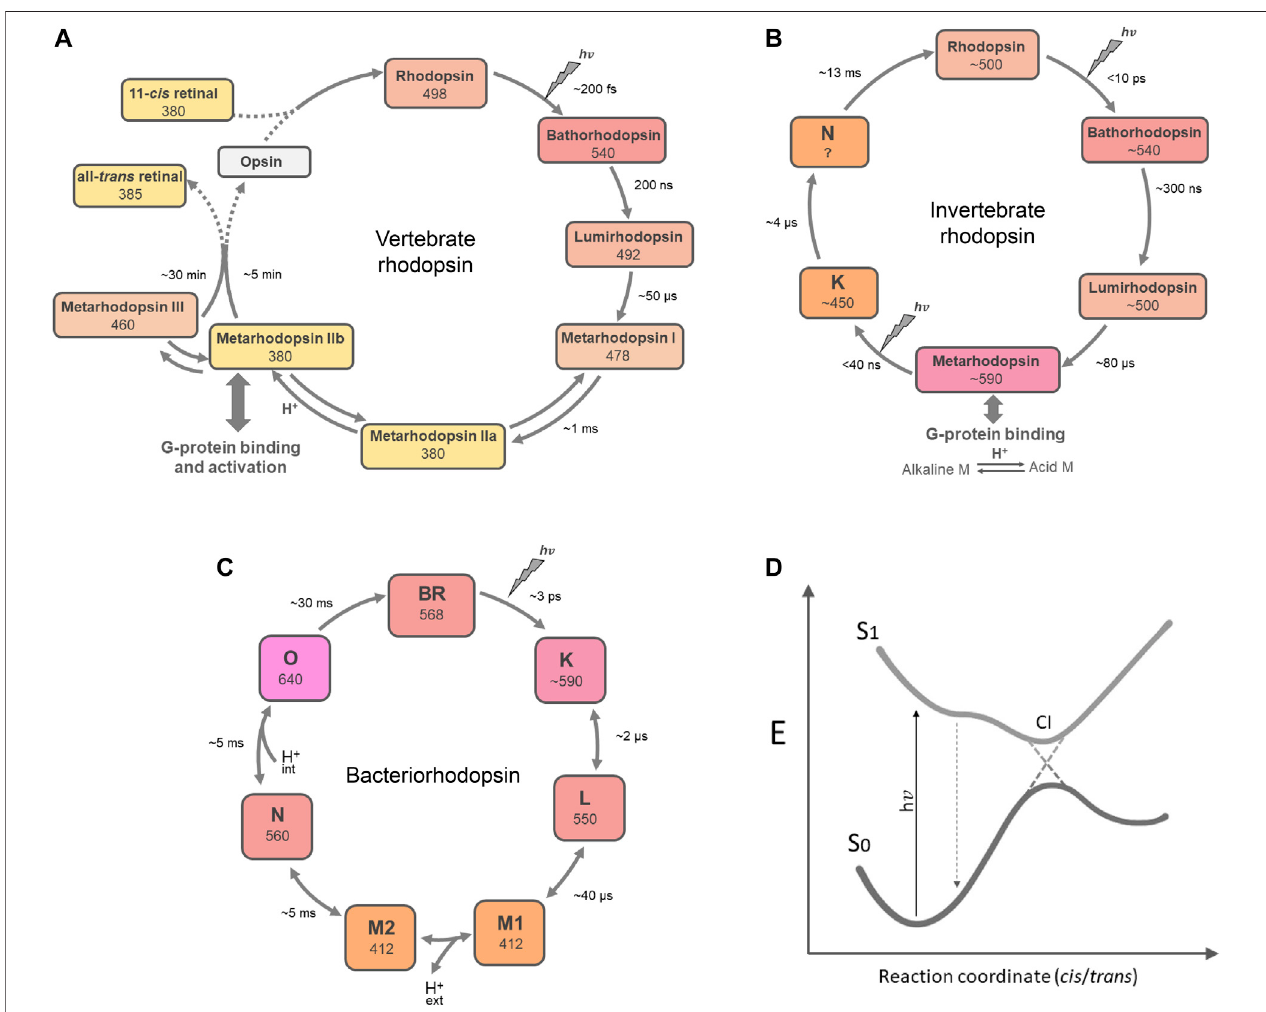
FIGURE 8 | Global presentation of the predominant photochemical pathways in the rhodopsin families. (A) Bovine rod rhodopsin as the archetype of the monostabletype-2pigments, (B) squid/ fl yvisualpigmentchimera,typical forthebistable type-2pigments, and (C) bacteriorhodopsin (BR)asaprototypeforthetype-1 pigments.The “ darkstate ” 11- cis ,15- anti chromophorecon fi gurationintype-2pigmentsisphoto-excitedintoall- trans. Theall- trans chromophorecon fi gurationintype- 1 pigments is photo-excited into 13- cis , 15- anti , which thermally relaxes, eventually returning to the ground state. The early photo-intermediates still contain a protonated Schiff base and relax thermally to deprotonated Meta II or M states. In proton pumps like BR this is accompanied by opening up proton pathways in the protein,whileinmosttype-2pigmentsbindingofaGproteinisinitiated.Atthisstage,thepathwaysdivert,asfurtherexplainedinthetext.Ofcourse,hereareexceptions: sometype-2pigmentscontainall- trans inthe “ darkstate, ” whichisphotoexcited into11- cis ,eithertochangeactivityortorelease11- cis retinal forregenerationofvisual opsins ( Table 2 ). Some type-1 pigments can also photo-generate 9- cis or 11- cis states with deviating photocycles and/or functions. (D) Simpli fi ed schematic of a conical intersection where the excited chromophore at the S1 energy surface can cross over to the S0 energy surface of the photoproduct. The S1 surface can contain thermal transitions, and in type-1 pigments the kinetics to reach and cross-over at the conical intersection also depend on the pKa of the direct counterion to the Schiff base (Chang et al.,